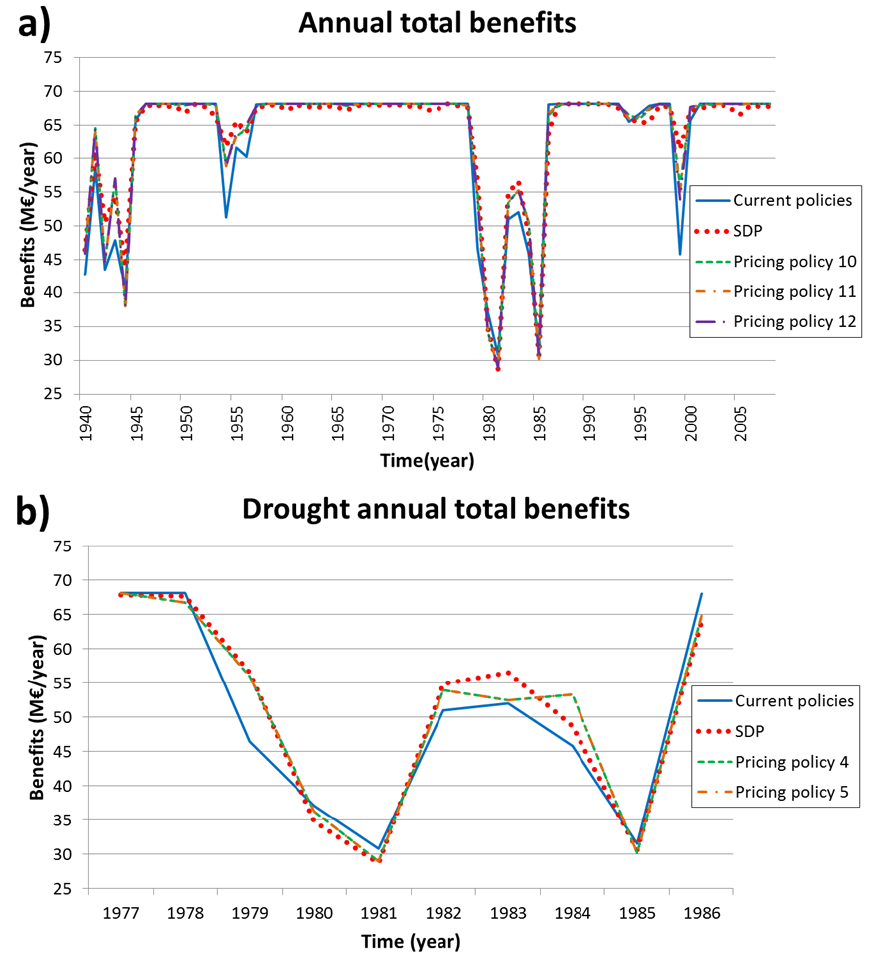
Figure 8. Annual total benefits comparison for the 1940–2009 period (a) and for the 1977–1986 drought (b)